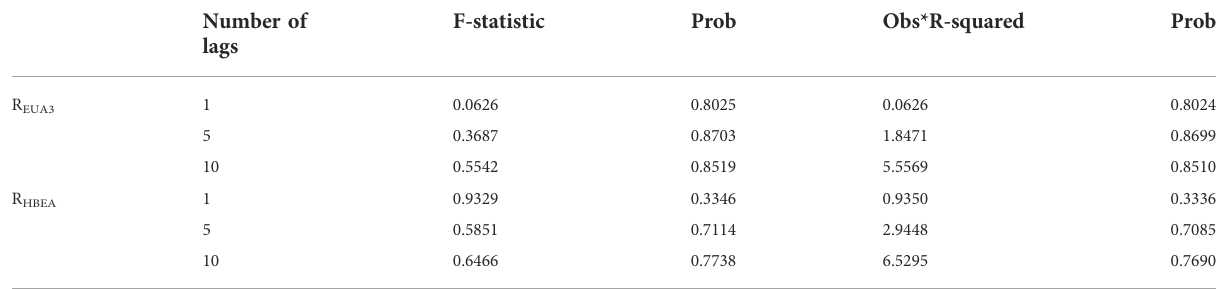
TABLE 13 ARCH-LM test results for residual series. The null hypothesis is that a series of residuals exhibits no conditional heteroscedasticity. The p -value represents the signi fi cance of the corresponding